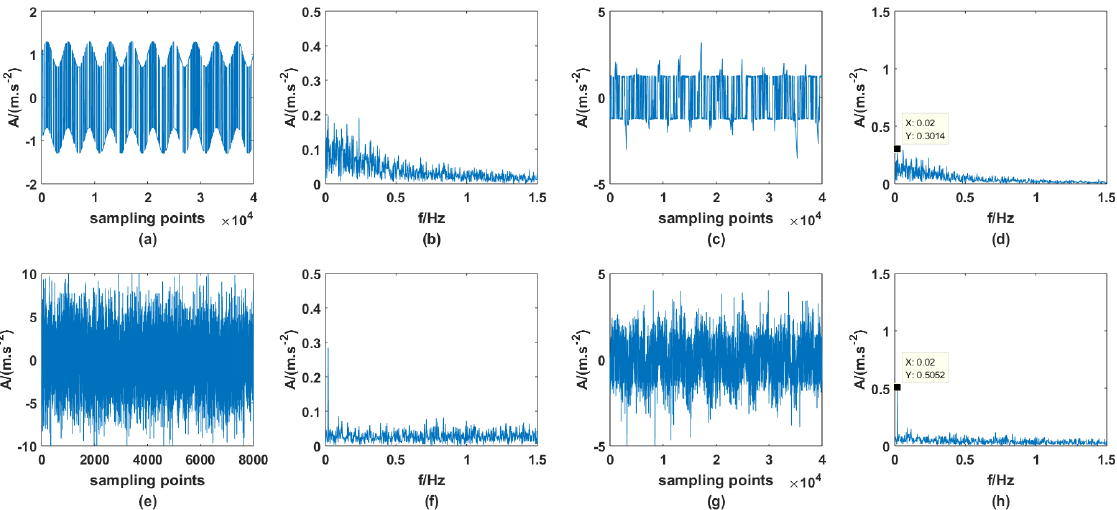
Figure 15. Comparison of high-value D ( a ) input time spectrum with dichotomous noise, ( b ) input frequency spectrum with dichotomous noise, ( c ) output time spectrum with dichotomous noise, ( d ) output frequency spectrum with dichotomous noise, ( e ) input time spectrum with AWGN, ( f ) input frequency spectrum with AWGN, ( g ) output time spectrum with AWGN, ( h ) output frequency spectrum with AWGN